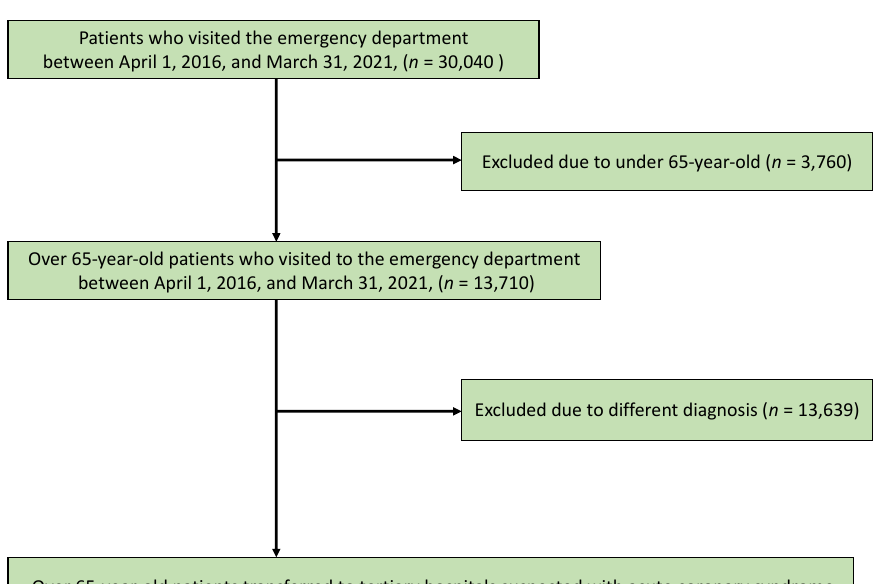
Figure 1. Flow chart of patient selection.